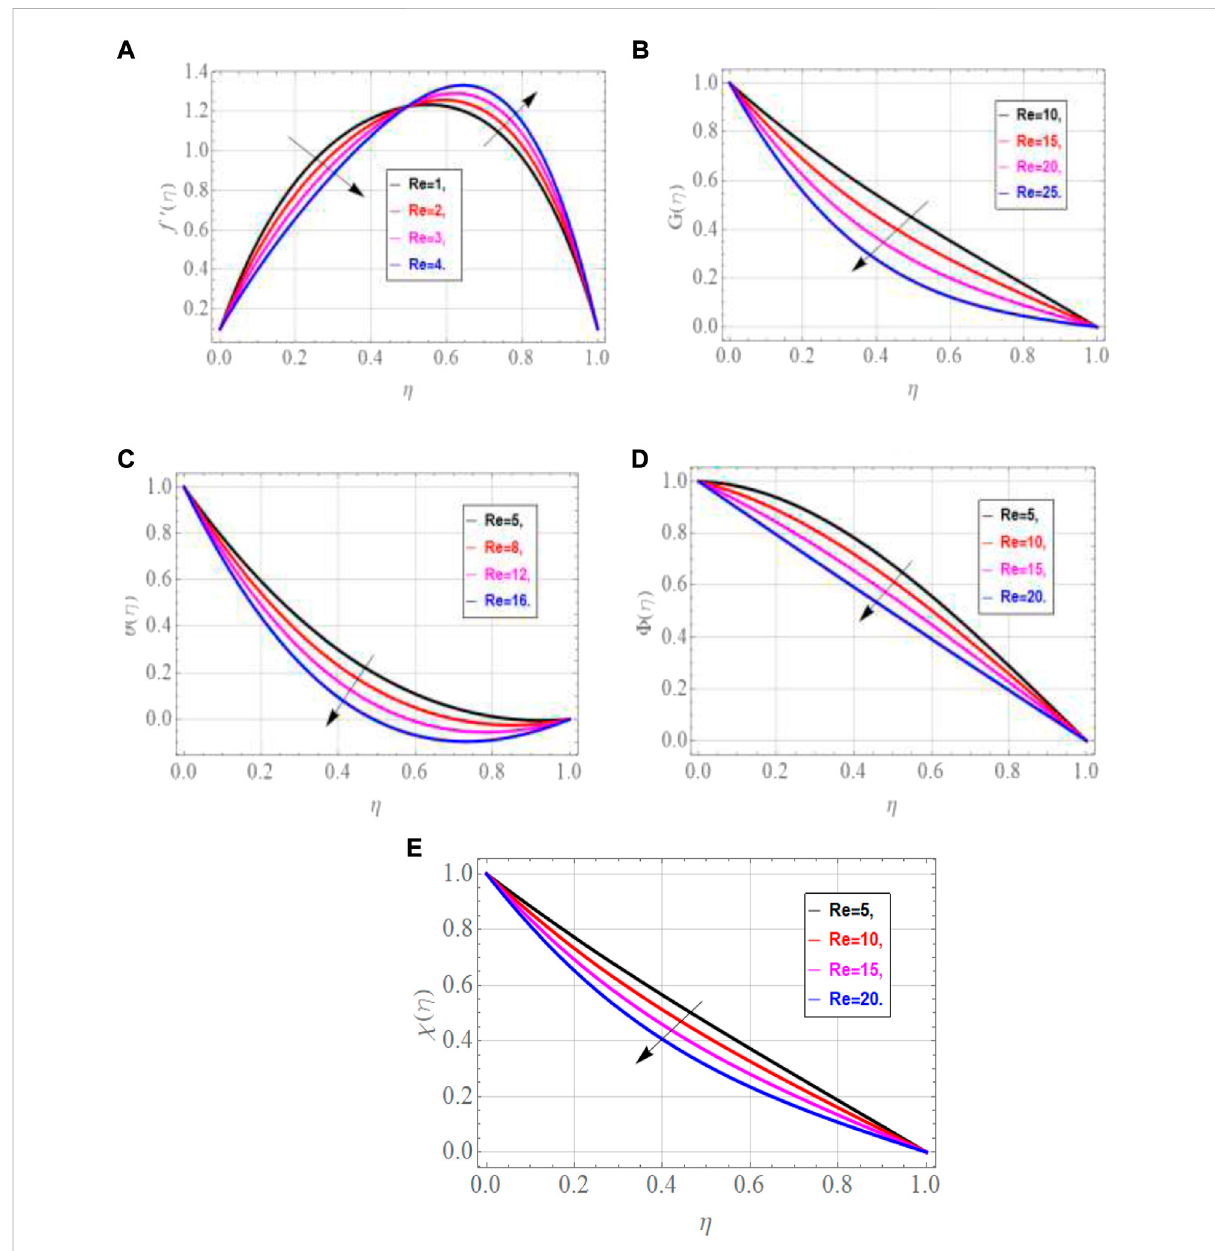
FIGURE 2 Impact of Re on f ′ ( η ) , G ( η ) , θ ( η ) , Φ ( η ) , χ ( η )